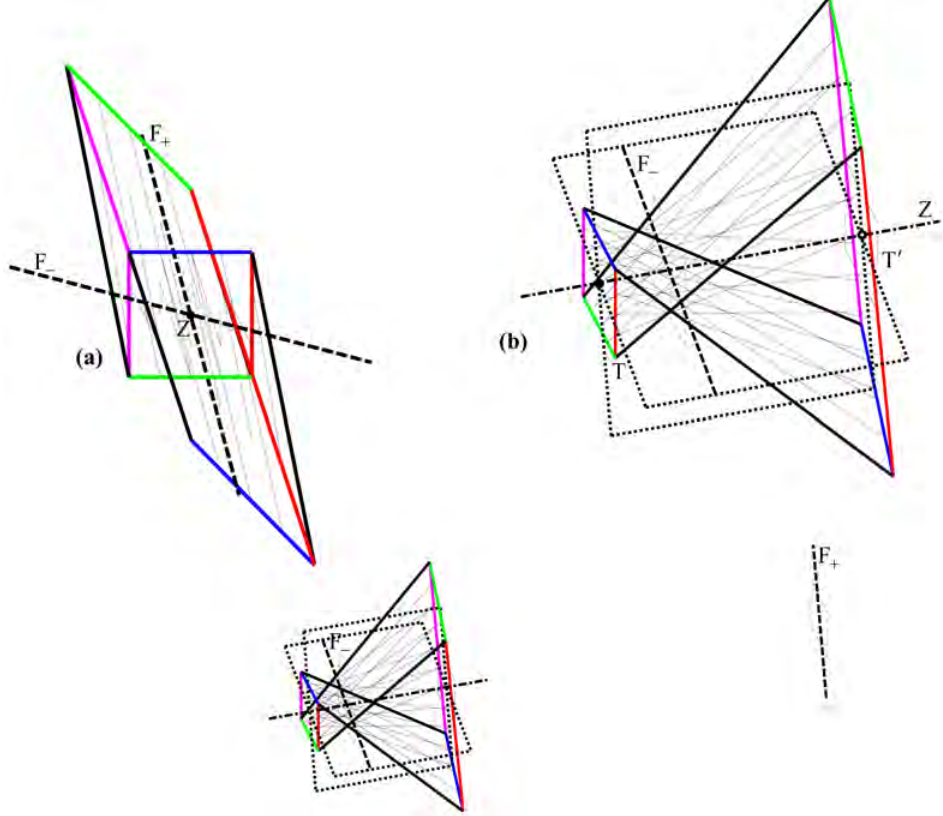
Figure 18 A pencil with divergency 2/ LJIM ++−= D at T. Relative to Figure 17 the principal meridional planes have rotated further towards each other and the focal planes continue to approach one another. The second focal plane, shown in (c), is now at a reduced distance of about 7.5 m. (b) azimuth °− 20 17 °− 20 , elevation 36 °− 20 .